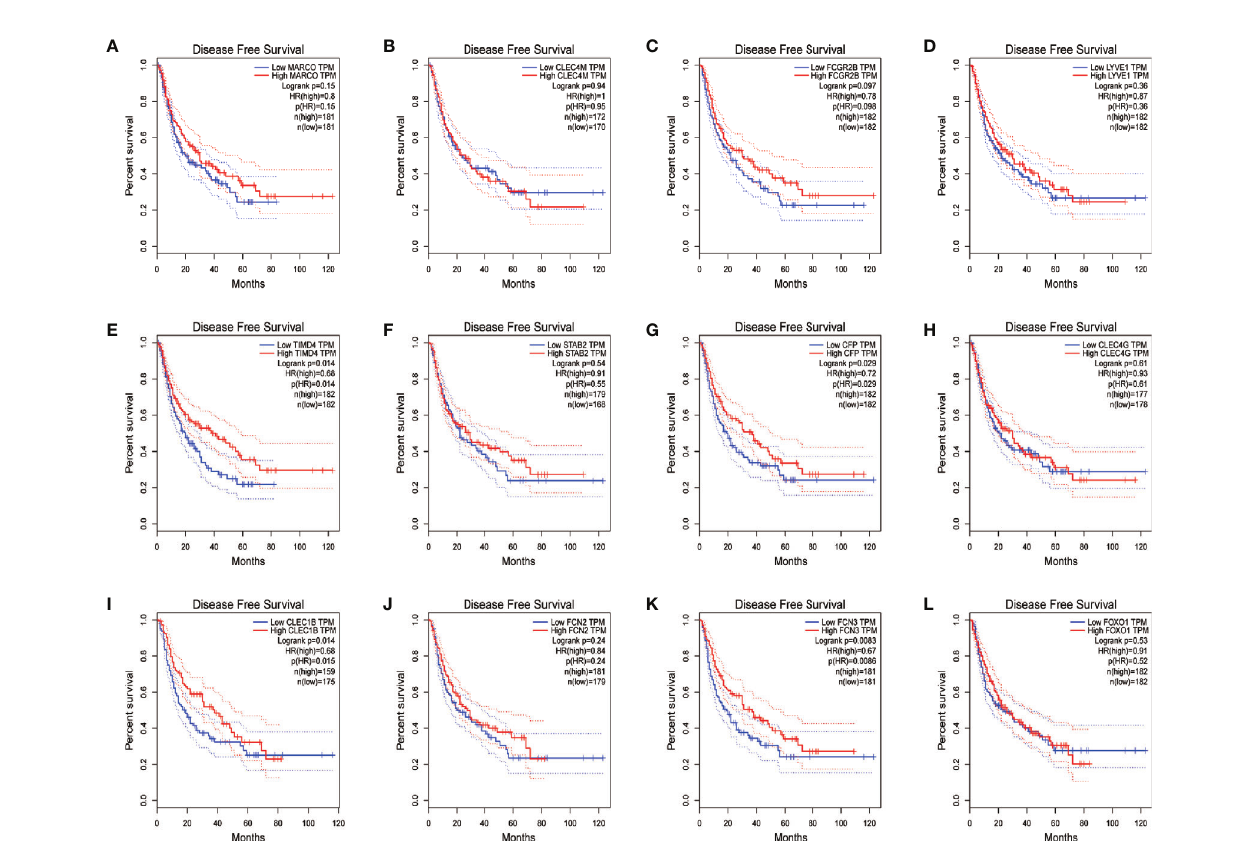
FIGURE 11 | Disease-free survival (DFS) analyses of hub genes. (A) MARCO, (B) CLEC4M, (C) FCGR2B, (D) LYVE1, (E) TIMD4, (F) STAB2, (G) CFP, (H) CLEC4G, (I) CLEC1B, (J) FCN2, (K) FCN3 and (L) FOXO1. The red line represents samples with high gene expression, and the blue line represents samples with low gene